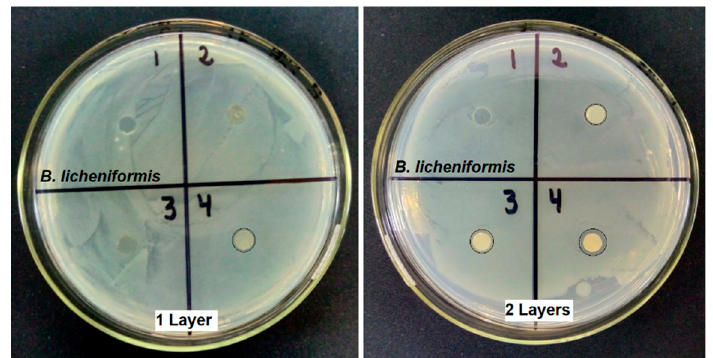
Figure 14. Inhibition zone of the PEEK (1), PEEK/Ag0.04 (2), PEEK/Ag0.08 (3) and PEEK/Ag0.12 (4)